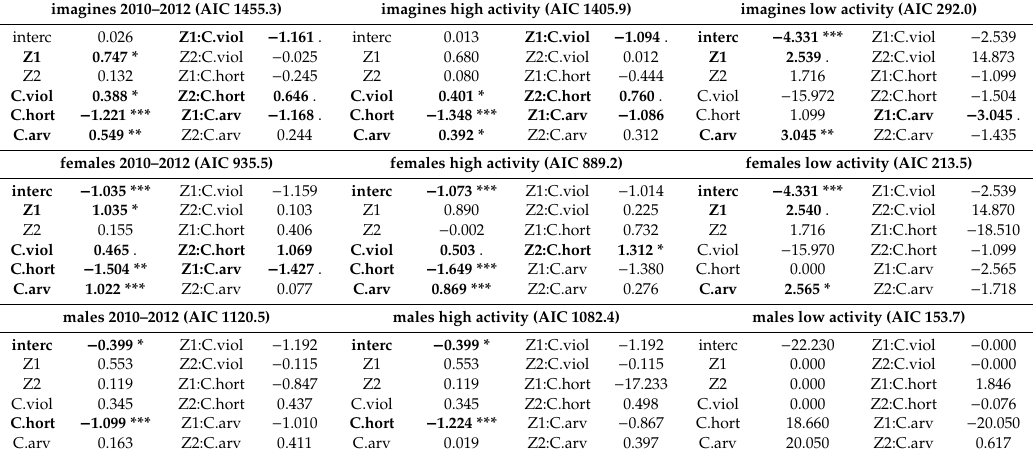
Table 4. Parameters of the generalised linear model (glm) for interspecific comparisons taking into account the three zones of influence and sex, and di ff erentiated by periods of activity. (The levels